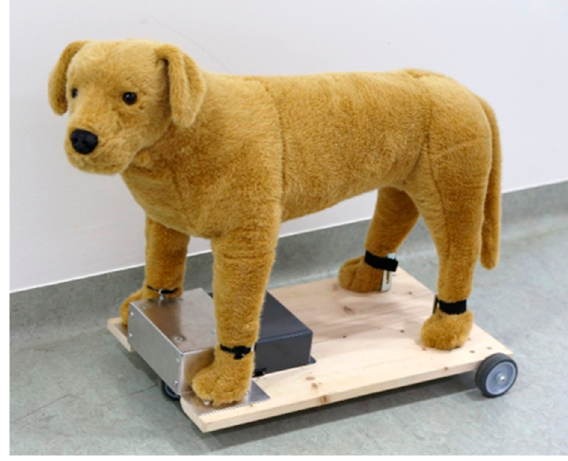
Figure 1. Fake dog mounted on board with wheels that could be moved via remote control.